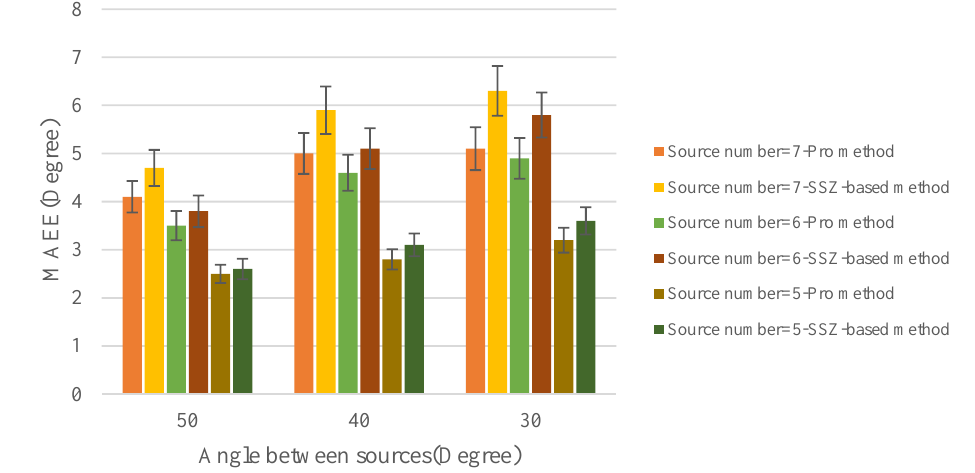
Figure 9. MAEE versus angle between sources in anechoic condition.